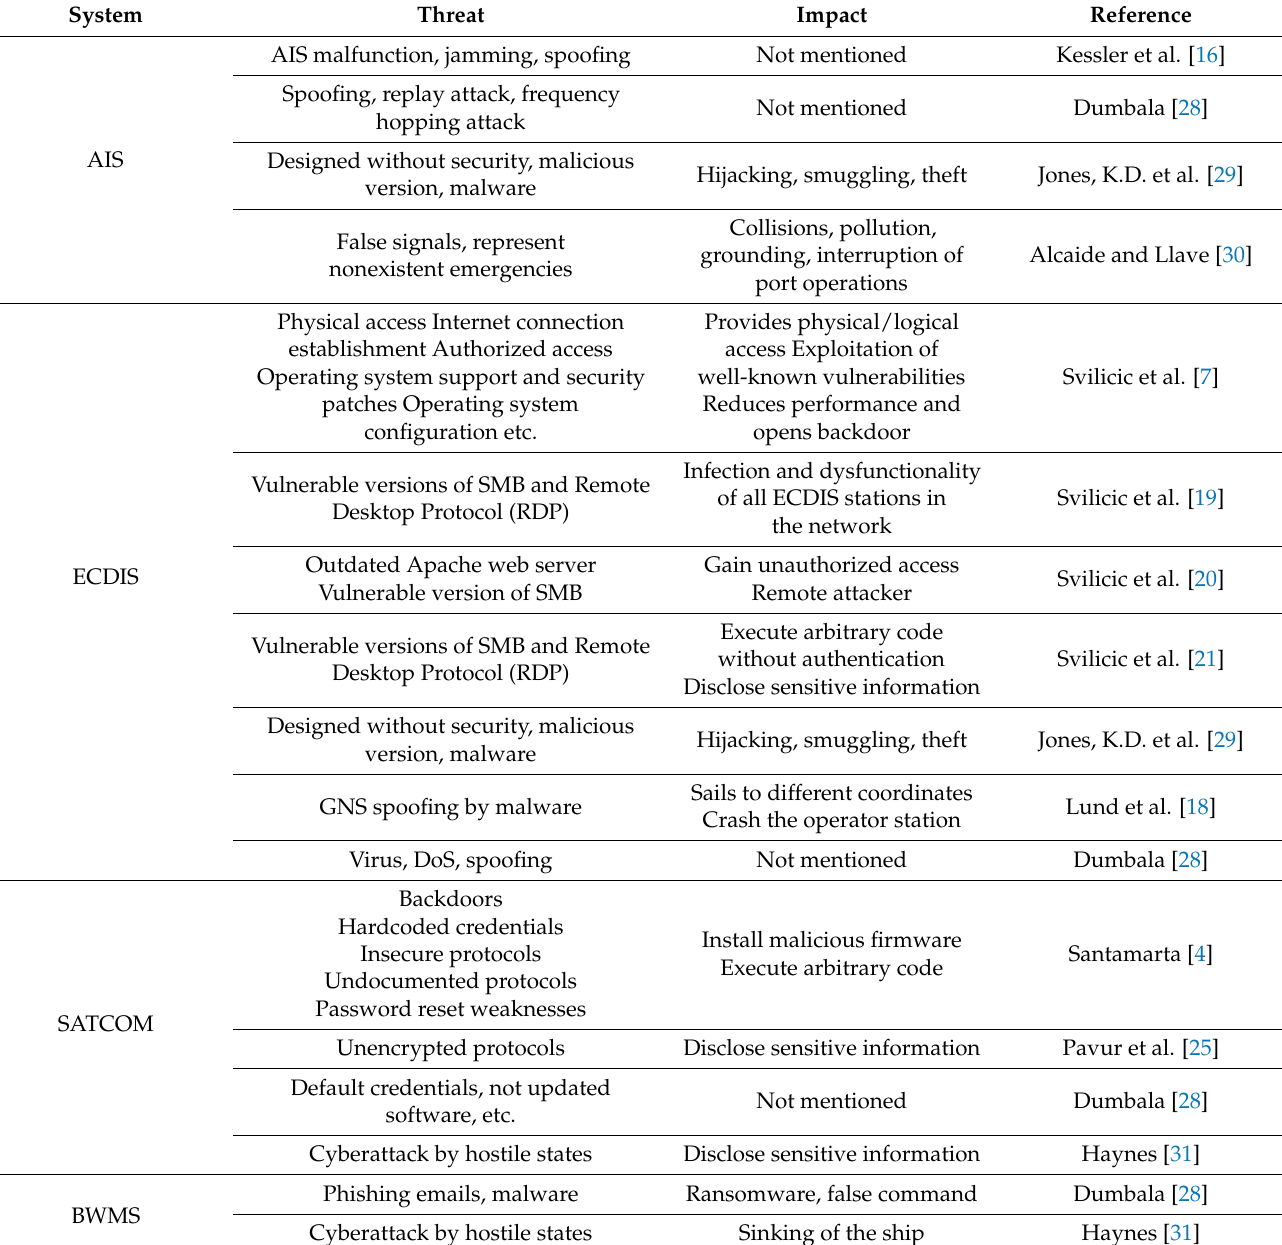
Table 2. Summary of